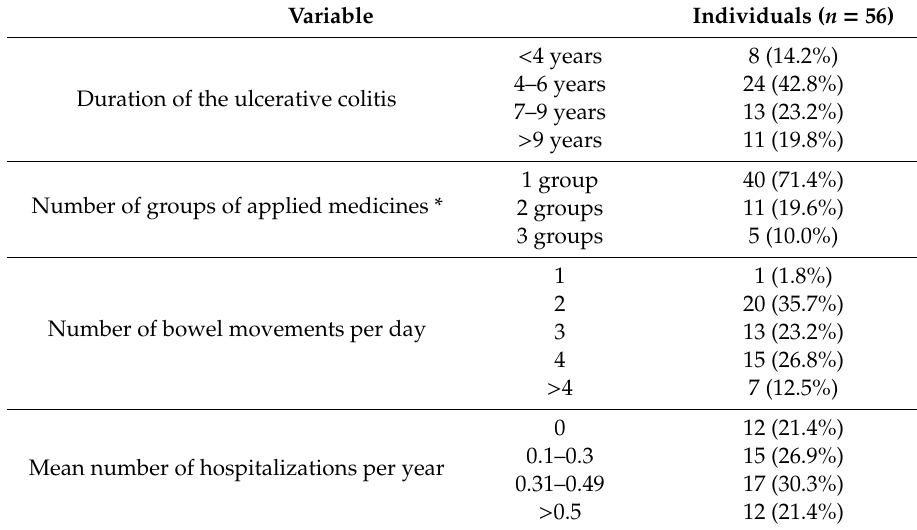
Table 1. The basic characteristics of the disease course for the studied